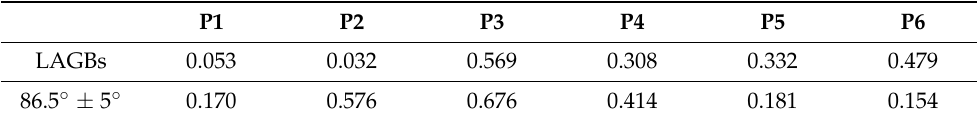
Table 3. The fraction of LAGBs and 86.5 ◦ twin